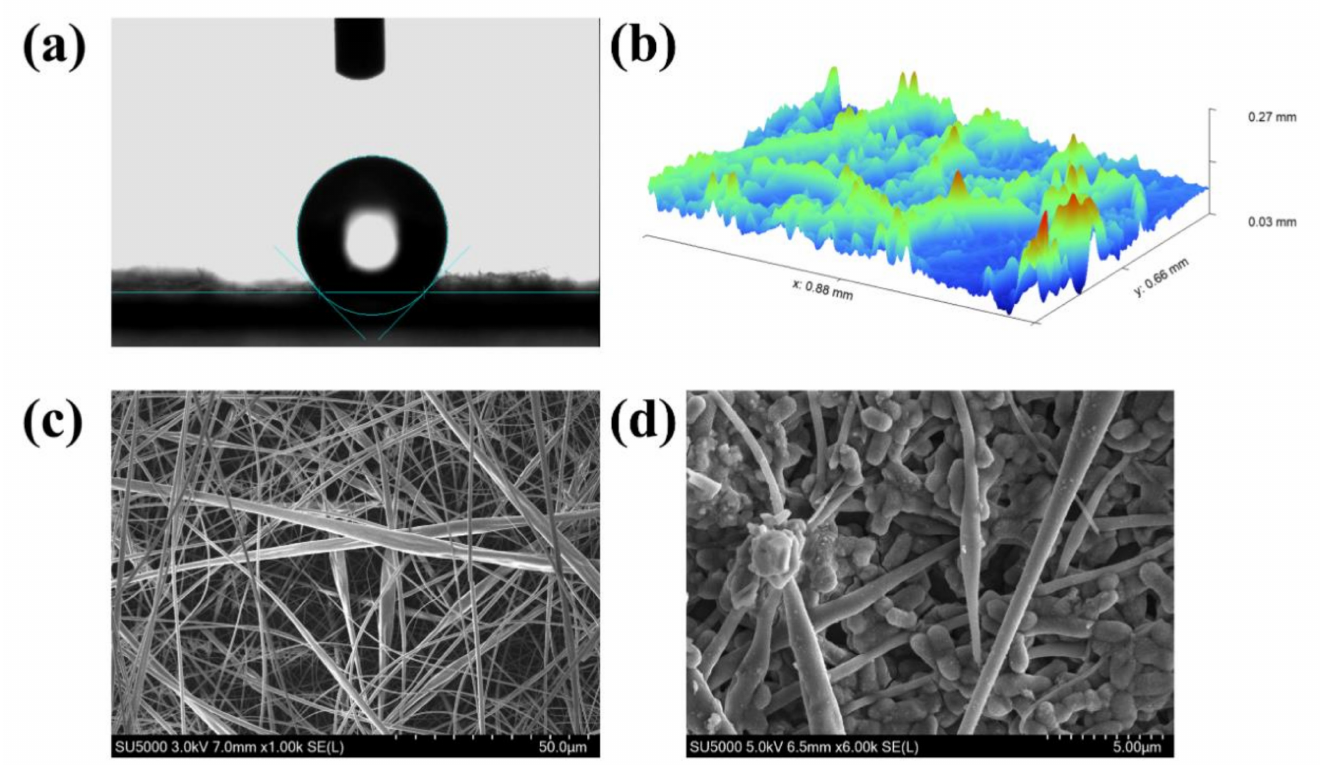
Figure 1. ( a ) Water contact angle; ( b ) 3D profile information map; ( c ) SEM image of ethyl cellulose